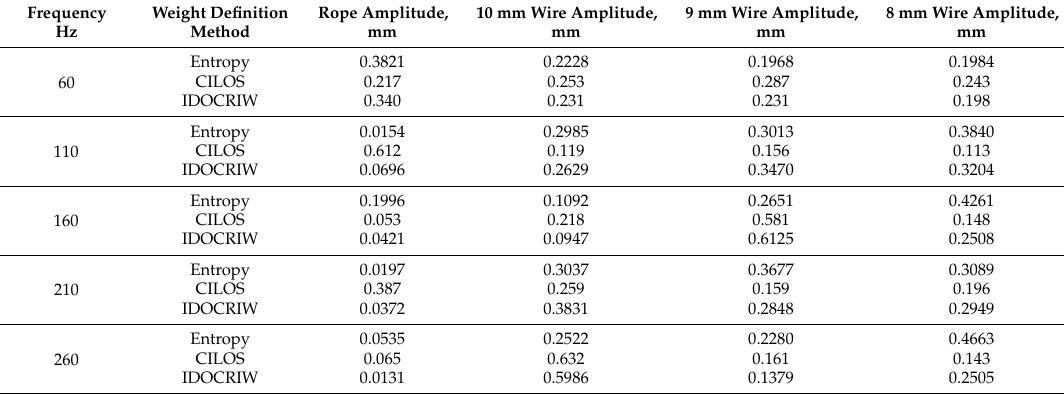
Table A2. Comparison between MCDM methods of entropy, CILOS and